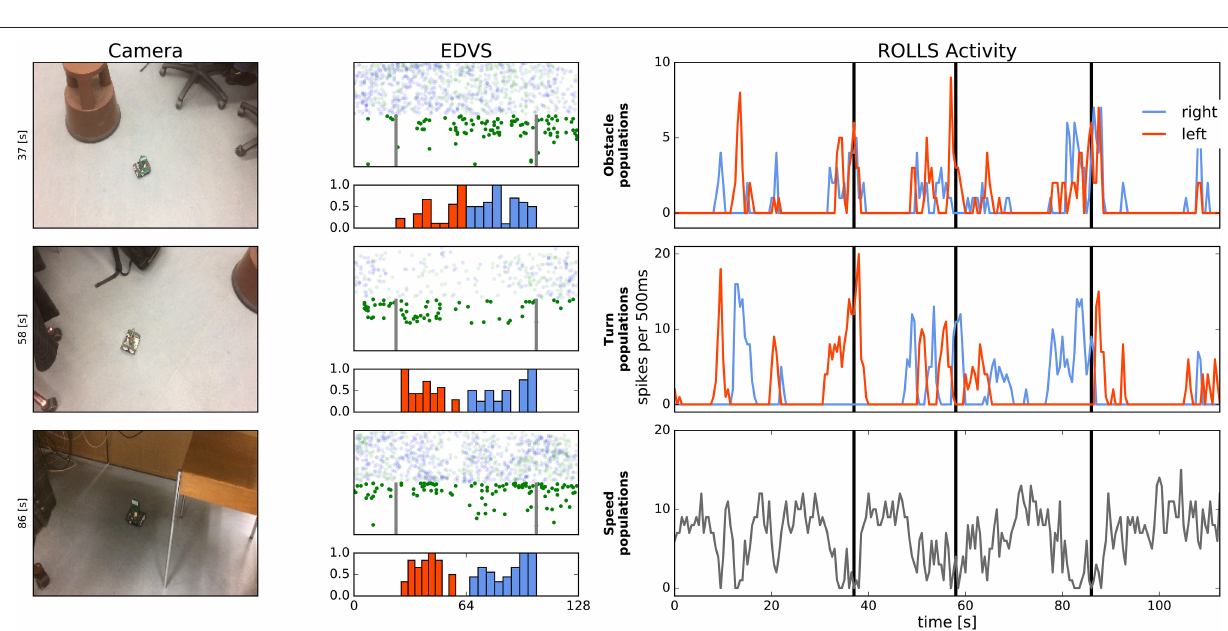
FIGURE 13 | Robot driving in the office environment. Left: Snapshots from the video camera showing robot at three time points during the experiment. Middle: Events from the DVS camera and histogram of these events, binned over 500 ms in columns in the region between two vertical lines, which were used to drive obstacle populations on the ROLLS. Each pair of the eDVS events and histogram corresponds to the time point of the video frame in the Left column. Note that 80% of events are randomly dropped here and only “on” events are shown in the relevant region (lower part of the screen). Events above the midline of the image sensor are shown with transparency (these events were not used for obstacle avoidance). Right: Activity of the obstacle (left and right), drive (left and right), and speed neuronal populations over time (summed activity across each population). Vertical lines mark time point that correspond to the video frames in the Left